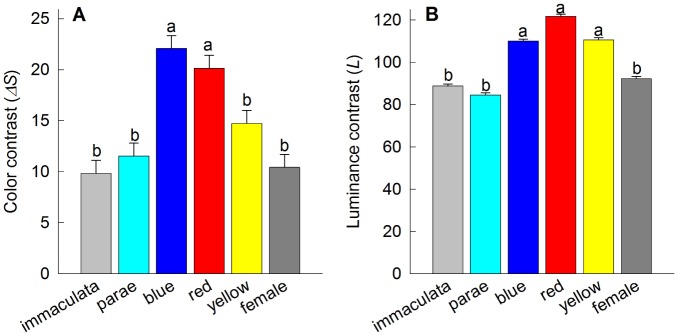
Mean (+1SE) (A) color contrast (ΔS) and (B) luminance contrast (L) as viewed through the hexachromatic visual system of Poecilia parae.Female and male color phenotypes with different letters are significantly different at P<0.01 (Fisher LSD post-hoc comparisons). Error bars represent 95% confidence intervals.